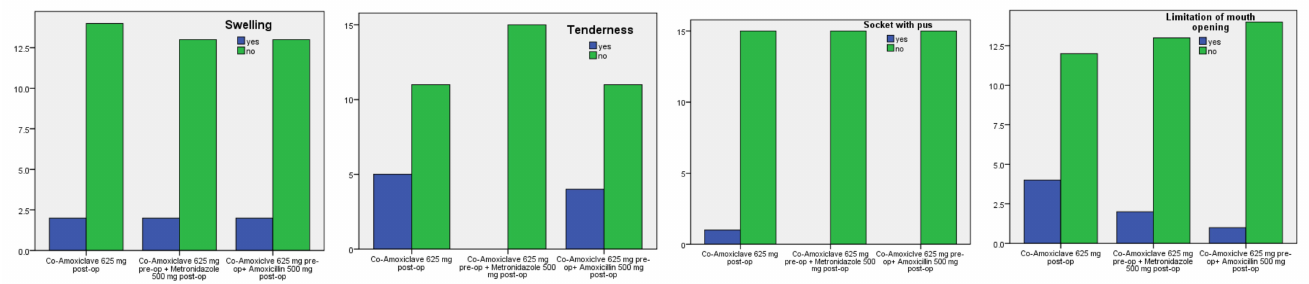
Figure 3. Distribution of surgical site infection (SSI) cases among the oral antibiotics